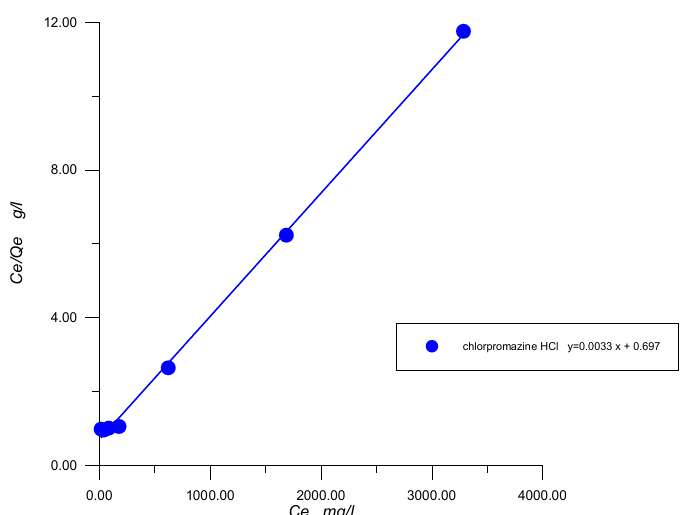
Figure 3: The linear form of the Langmuir equation of the adsorption of chlorpromazine on bentonite at 37.5 o